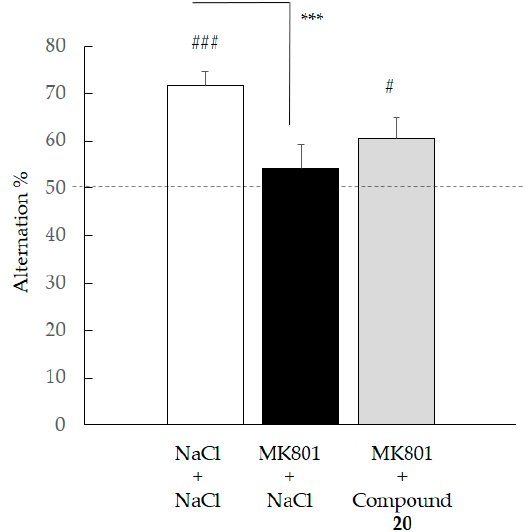
Figure 9. Effect of compound 20 on MK 801 induced impairment during the spontaneous alternation test. Data are expressed as the mean ± standard deviation (SEM, n = 8–10 per group). NaCl and compound 20 (1 mg/kg) were administered IP 30 minutes before the test, MK801 (0.1 mg/kg) was administered SC 20 minutes before the test. (# p < 0.05, ### p < 0.001 versus 50%; univariate t -test). (*** p < 0.05 versus MK801, SNK test).